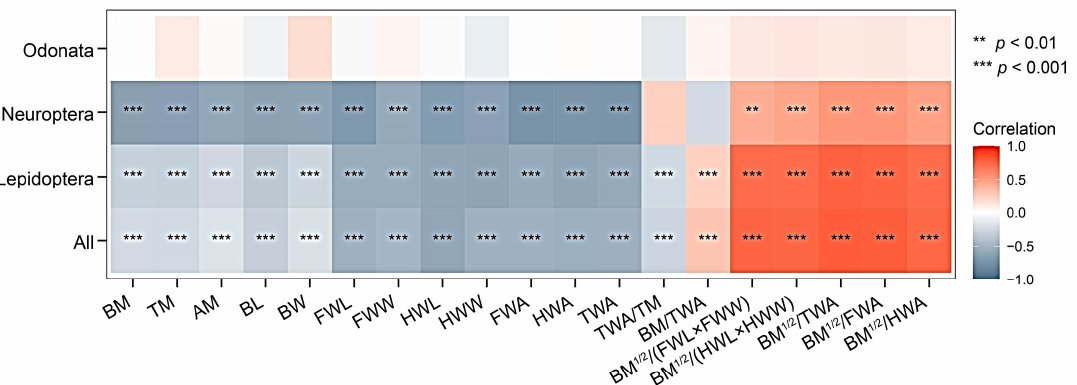
Figure 3. Correlations between wingbeat frequency and morphometrics. BM, body mass; BM 1/2 , the square root of body mass; TM, thoracic mass; AM, abdominal mass; BL, body length; BW, body width; FWL, forewing length; FWW, forewing width; HWL, hindwing length; HWW, hindwing width; FWA, forewing area; HWA, hindwing area; and TWA, total wing